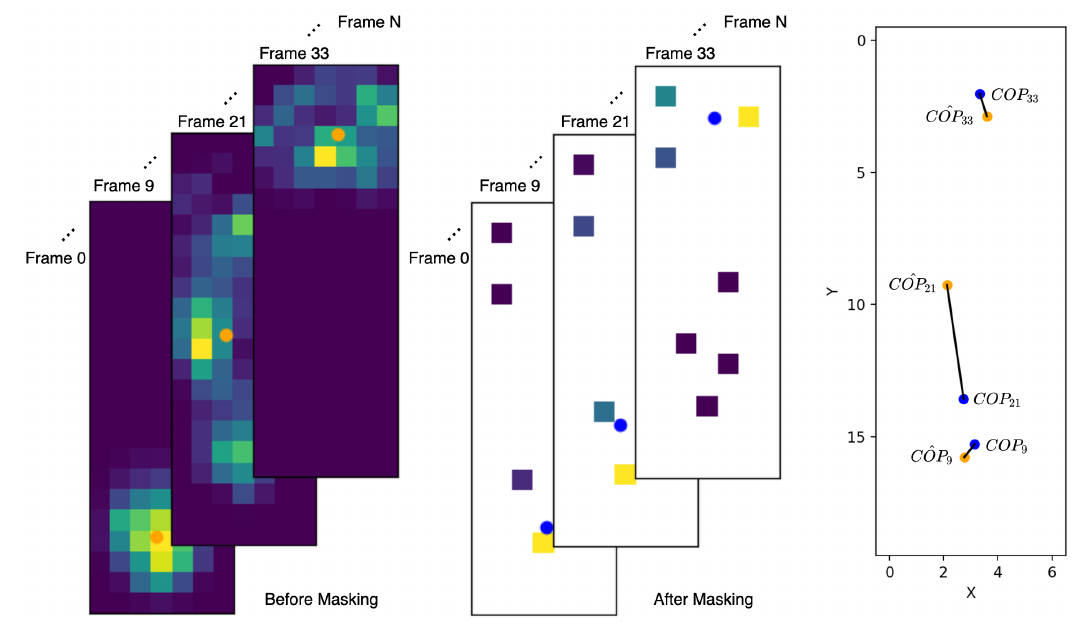
Figure 3. The distance between masked and non-masked COP positions. For demonstration, we chose three frames in this plantar pressure video, the orange dot is the non-masked COP position and the blue dot is the masked COP position. The black line is the distance between these two COP positions at each